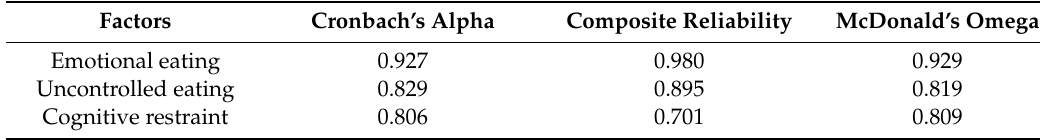
Table 9. The reliability of the measuring tools applied.